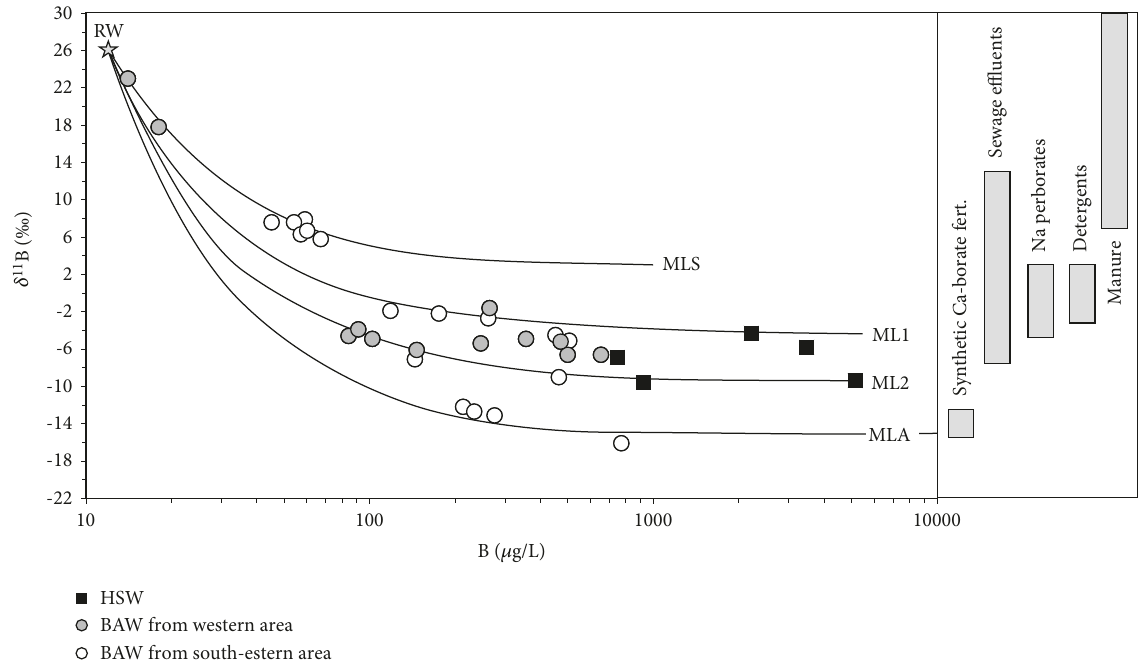
Figure 4: δ 11 B ( ‰ ) versus B content ( μ g/l) binary plot. ML1 and ML2 curves indicate the mixing between local meteoric end-member (rainwater =RW, δ 11 B = +26 ‰ ; B = 12 μ g/l ) and range of isotopic values of the HSW group ( δ 11 B = − 4 3 ‰ and − 9.6 ‰ ; B = 5130 μ g/l ). The MLA curve represents the hypothetical mixing behavior between local meteoric water and water-soluble anthropogenic boron compounds (synthetic Ca-borate fertilizers, average δ 11 B value of -13.5 ‰ and B = 30mg/l , [21]). The MSA mixing curve is drawn with following data (RW, and sewage e ffl uents with average δ 11 B value of +2.6 ‰ and B = 1000 μ g/l ; from Barth [43], Xue et al. [44], and Vengosh et al. [9]). Ranges of δ 11 B of sewage e ffl uents ( − 7.7 ‰ to +12.9 ‰ ; [9, 43, 44]), sodium perborates ( – 4.8 ‰ to +3.1 ‰ ; [2]), detergents ( − 2.9 ‰ to +3.1 ‰ ; [2]), synthetic Ca-borate fertilizers ( – 15 ‰ to – 12.1 ‰ ; [21]), and manure (+6.9 ‰ to +42.1 ‰ , [17, 44]) are shown for